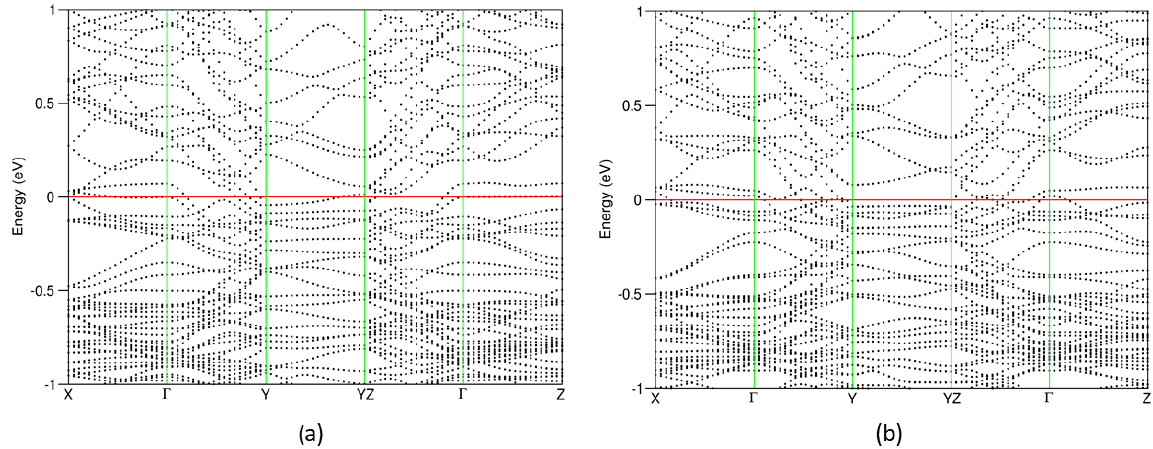
Figure 7. (Color on line) Dispersion curves of states around the Fermi level along the main axis for θ -Al 78 Fe 24 ( a ) and for θ -Al 76 Cu 2 Fe 24 phase ( b ). The red lines represent the Fermi level (at 0 eV).